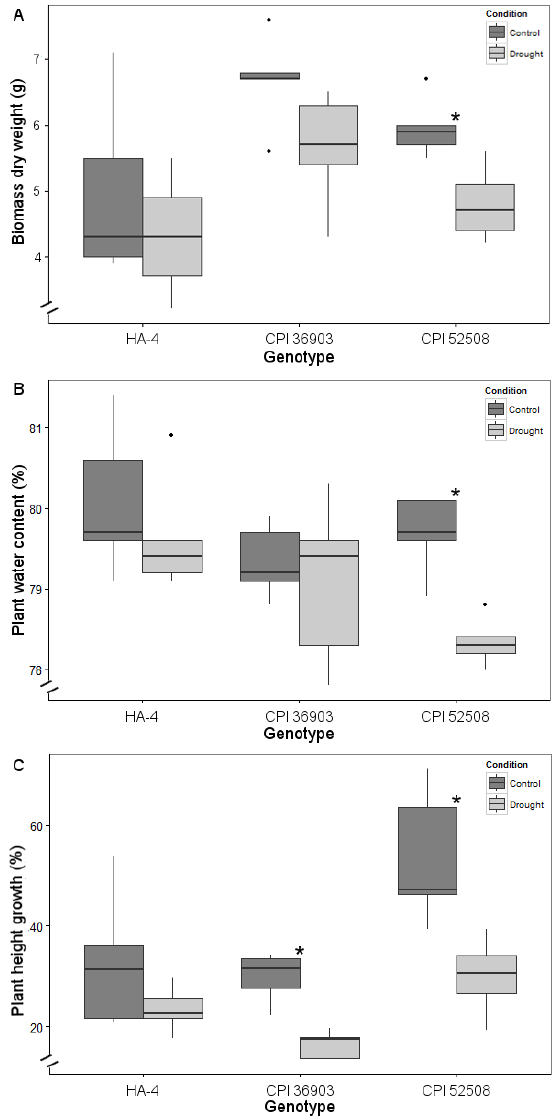
Fig. 2: Effects of water limitation after nine days on (A) biomass dry weight (g) (n=5), (B) plant water content (%) (n=5) and (C) plant height growth (%) (n=4-5); genotypes with * = p <0.05, exp. 2.